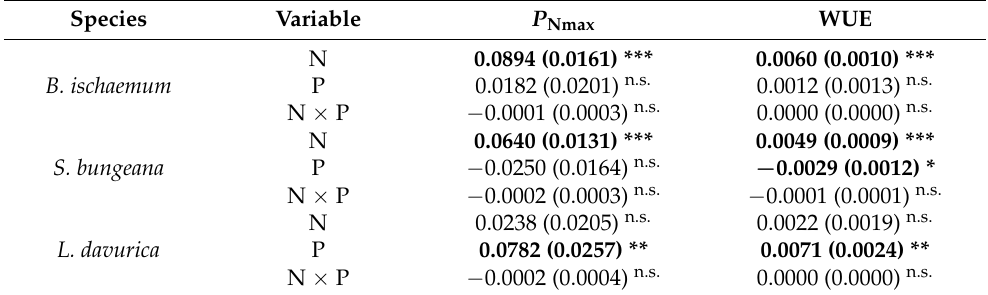
Table 2. Regression slopes (SE) derived from the multiple linear regression analysis between pho- tosynthetic characteristics ( P Nmax and WUE) and N addition, P addition, and N and P addition interaction in the three species. Species Variable P Nmax WUE